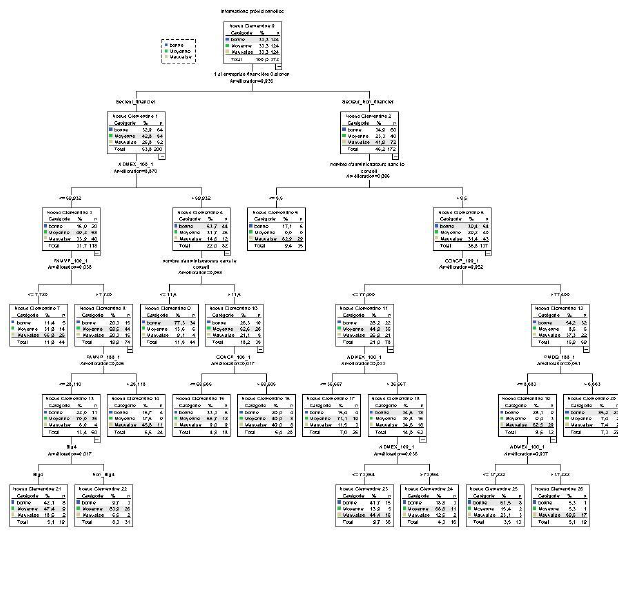
Figure V – Decision Tree: Forecasting